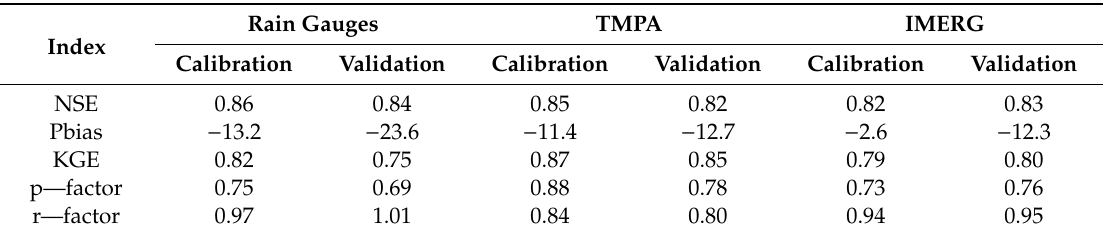
Table 3. Statistical metrics of SWAT streamflow simulation for both calibration and validation